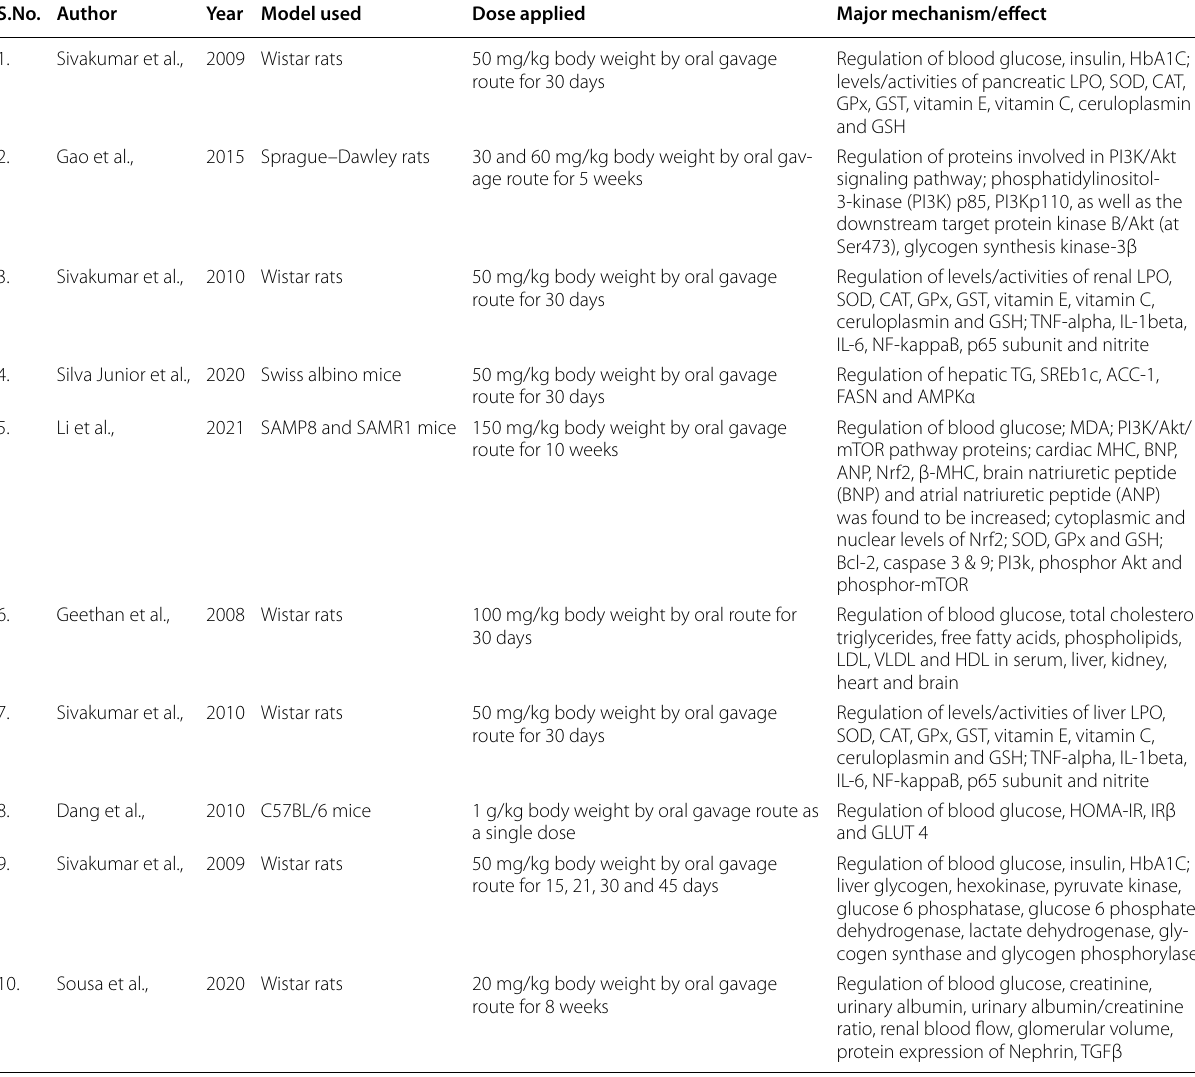
Table 1 Summary of the effects of d -pinitol on diabetes mellitus in experimental animals